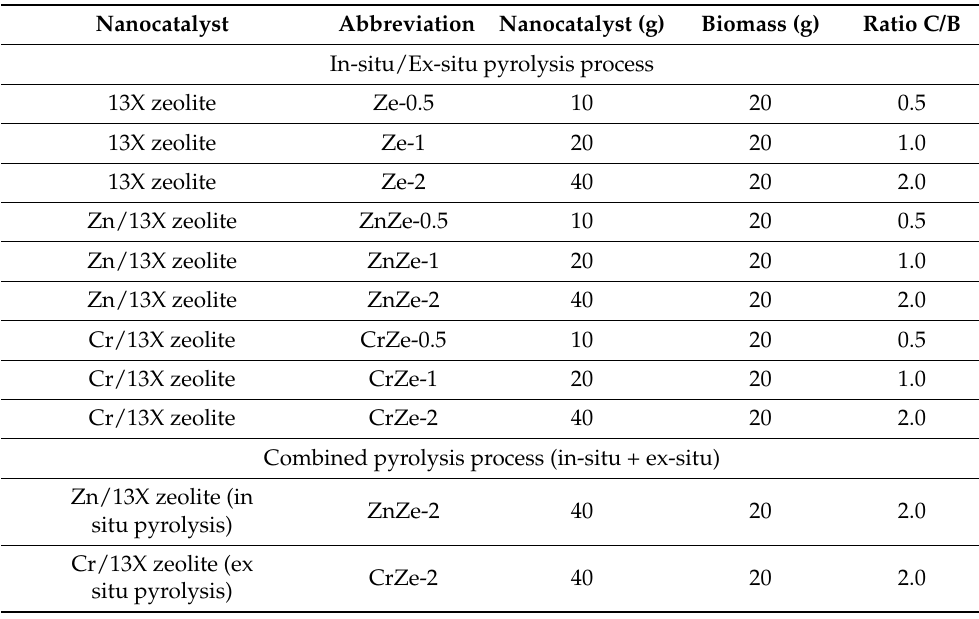
Table 1. Amount of biomass and catalyst employed in the in situ, ex situ, or in the combined pyrolysis